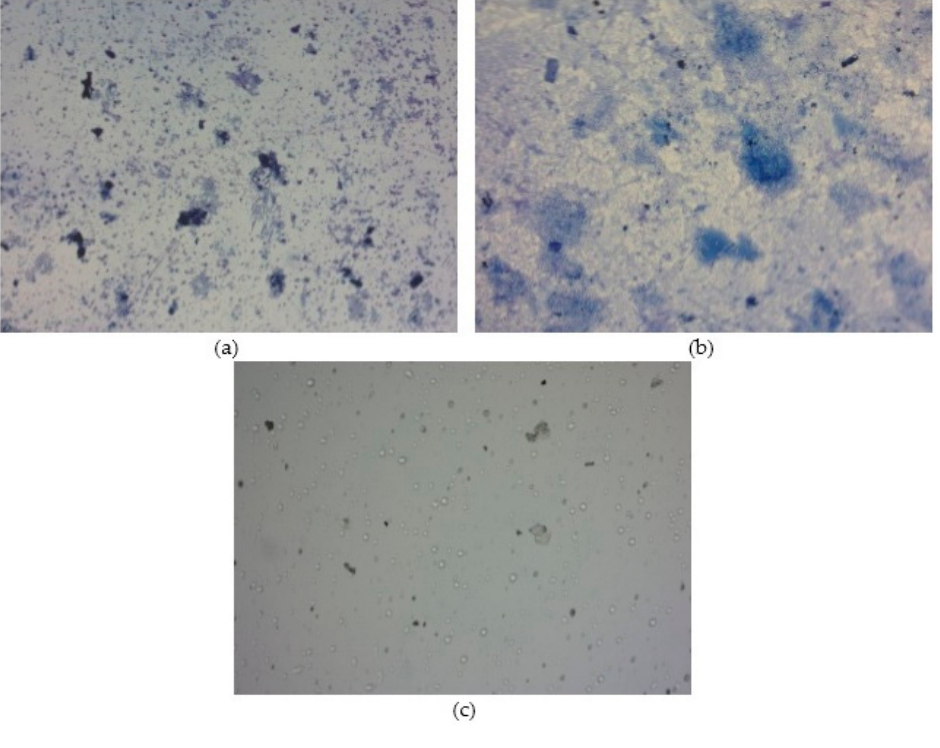
Figure 6. Optical microscope biofilm images. ( a ) The optical microscope image (10×) of a biofilm produced by C. albicans on Pall ring. ( b ) The optical microscope image (10×) of a biofilm produced by C. subhashii on Pall ring ( c ) Control image: clean Pall ring.